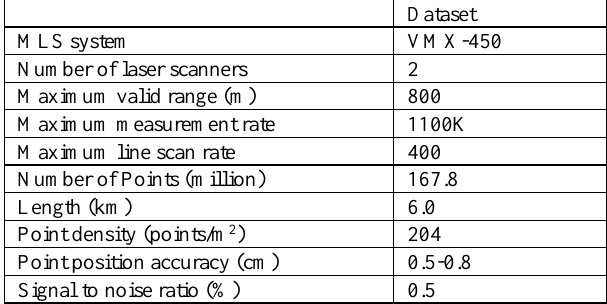
Table 1. Descriptions of the MLS system and point cloud.